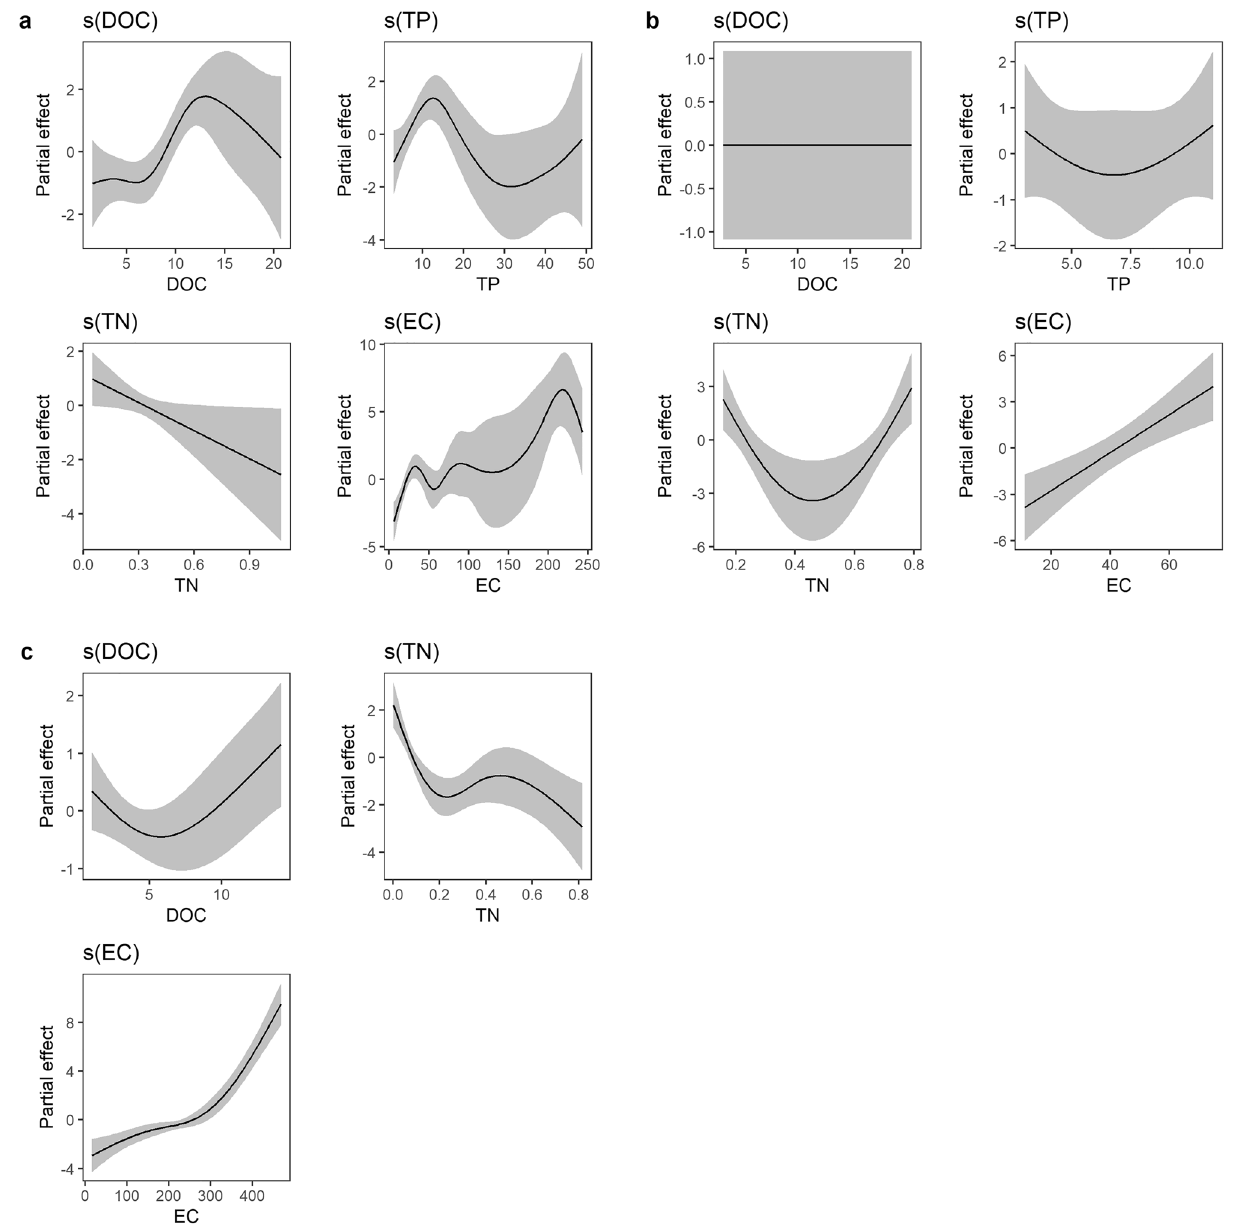
Figure 3. Result plots of the generalized additive models (gams) predicting CO 2 :O 2 saturation ratio for the three regions. In the Boreal lakes ( a ), the best predictor was DOC concentration followed by conductivity.